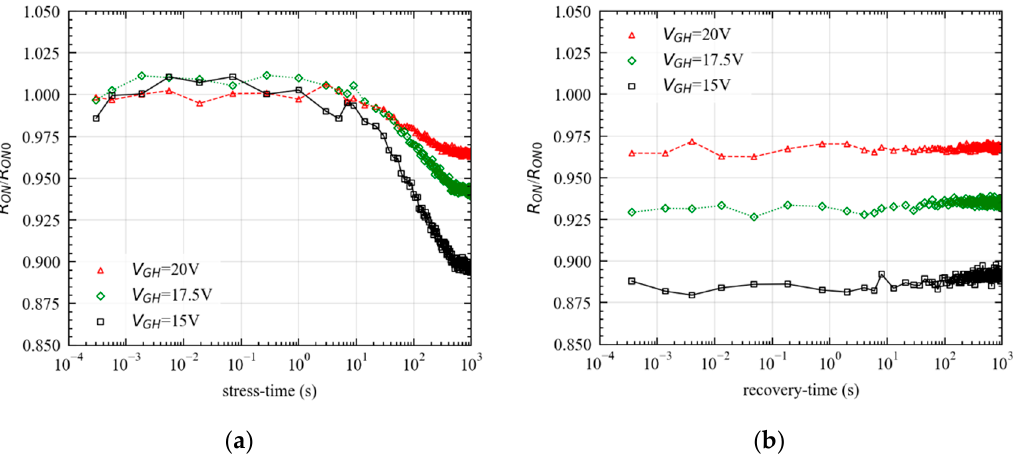
Figure 8. ( a ) Effect of gate voltage level ( V GH ) on the R ON drift during stress with V PH = 100 V. At an increasing V GH , the R ON transient amplitude decreases. ( b ) Monitored R ON recovery at different V GH levels (15 V, 17.5 V, and 20 V) with V PH = 100 V.